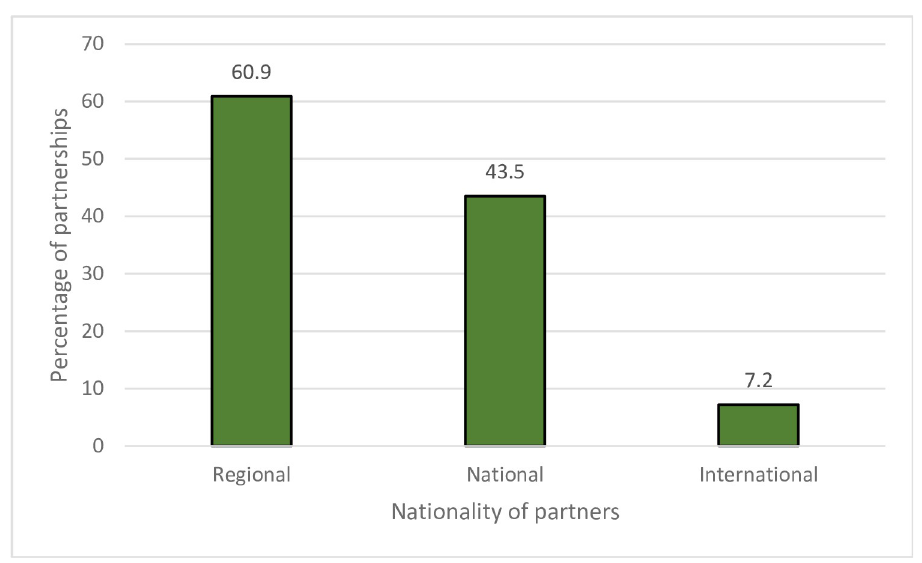
Fig 4. Nationality of actors participated in the partnerships.